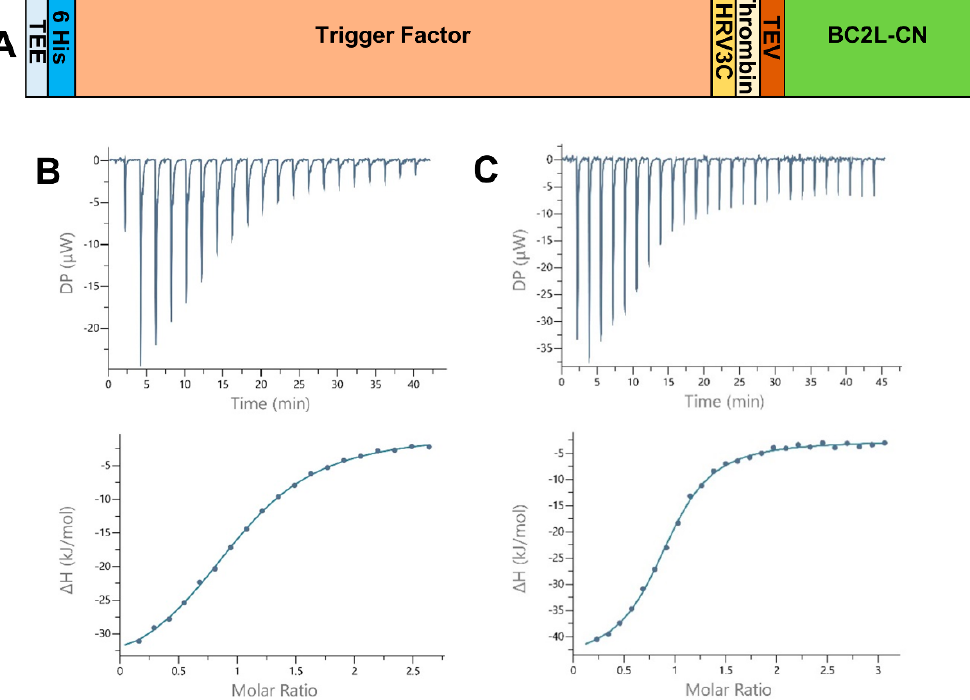
Figure 1. ( A ) Schematic of the expression construct of BC2L-CN2 in pCold-TEV. The N-terminal fusion presents a translation enhancing element (TEE), the trigger factor (TF) and 3 protease sites (human rhinovirus 3c (HRV 3c), thrombin, and tobacco etch virus (TEV)). The full construct leads to a protein of 605 and 134 amino acids before and after cleavage with the TEV protease. ( B , C ) Isothermal microcalorimetry data. Titration of rBC2L-CN2 (314–350 µM) by H-type 1 tetrasaccharide (( B ), 4 mM) and Globo H hexasaccharide (( C ), 10 mM) at 25 °C. The isothermal titration microcalorimetry (ITC) thermogram is displayed in the upper panel and the integration of data with curve fitted for “one binding site” model in the lower panel.